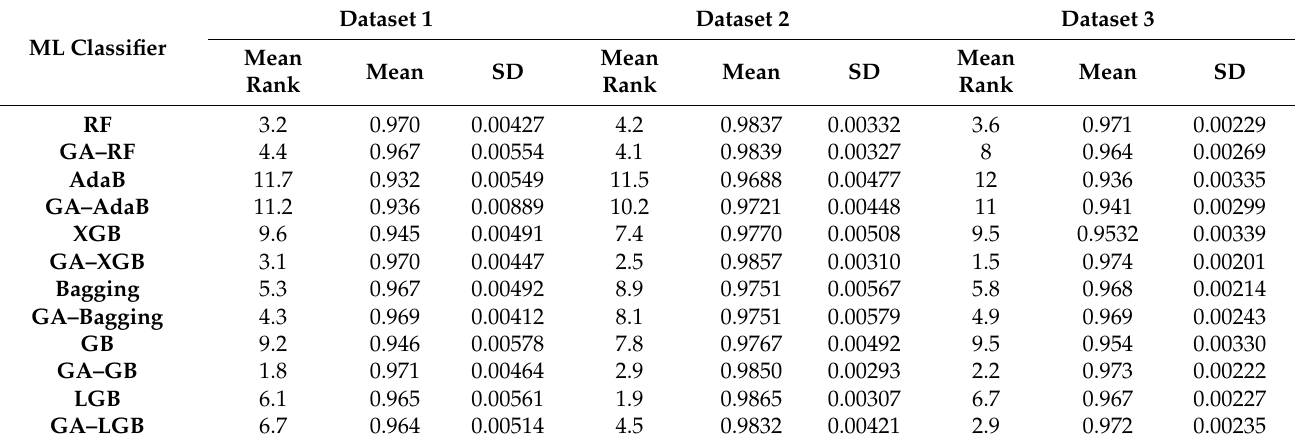
Table 11. Models ranked by accuracy of classifier obtained by 10-fold cross-validation.